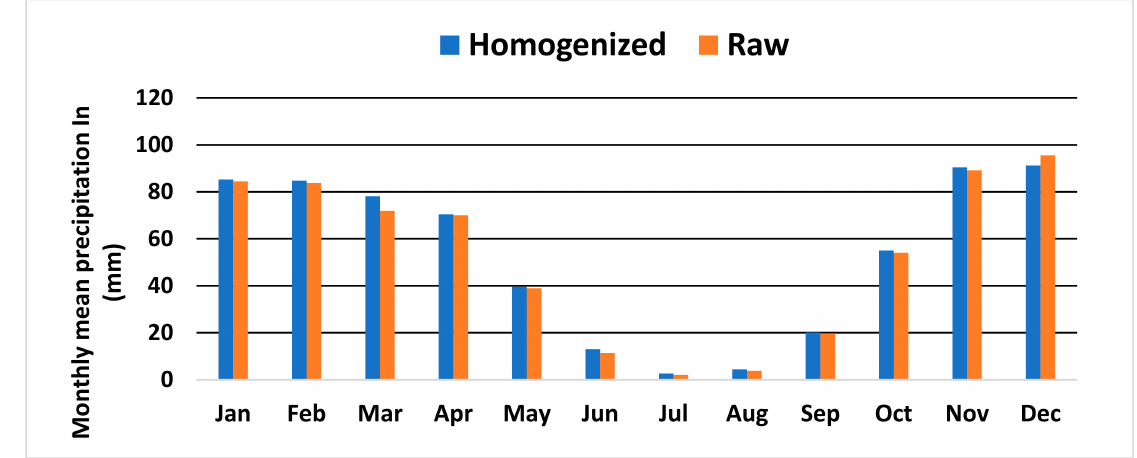
Figure 10. Monthly averages of raw and homogenized data for the Atlantic zone.